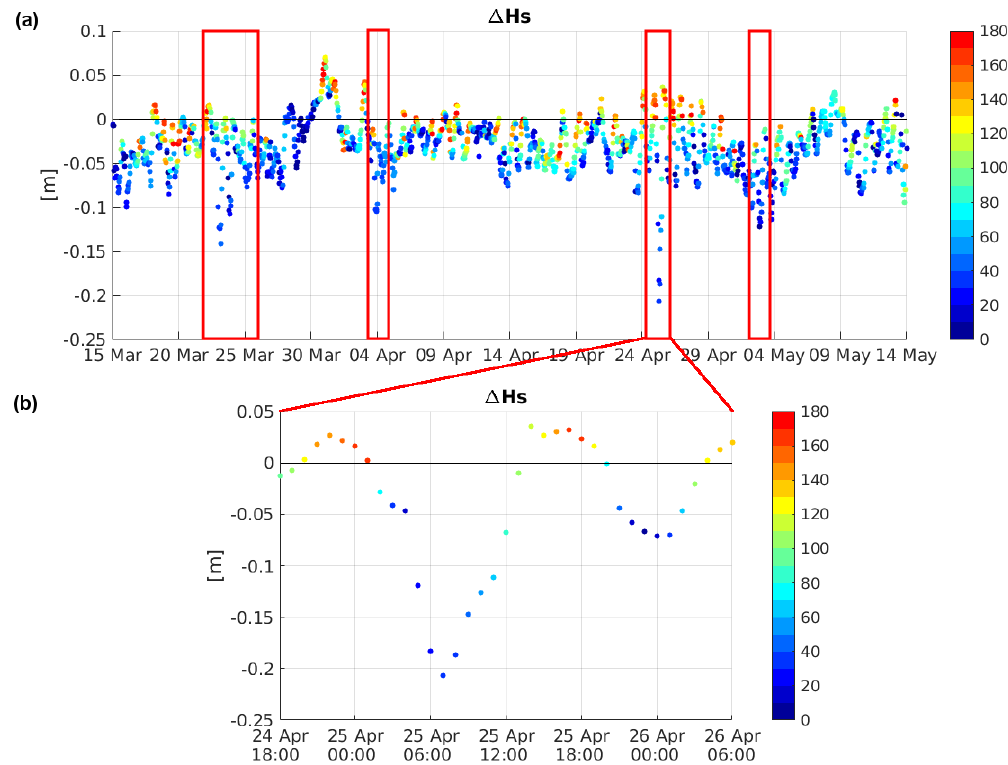
Figure 11. (a) Hs differences at P2. The different colors correspond to the angle between the directions of wave and current propagation. (b) Detailed view of the period corresponding to the E3